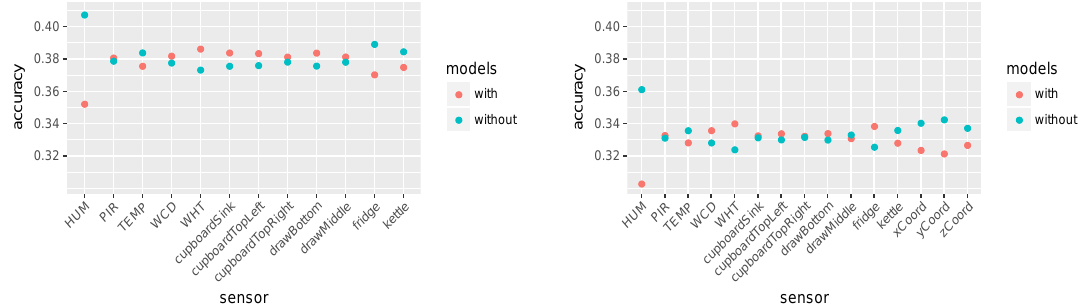
Figure 10. Mean accuracy with and without a given feature: ( Left ) the accuracy for all feature combinations without the camera features and using the first run (D1) for training and the rest for testing; and ( Right ) the accuracy of all feature combinations including the camera features and using leave-one-out cross validation.